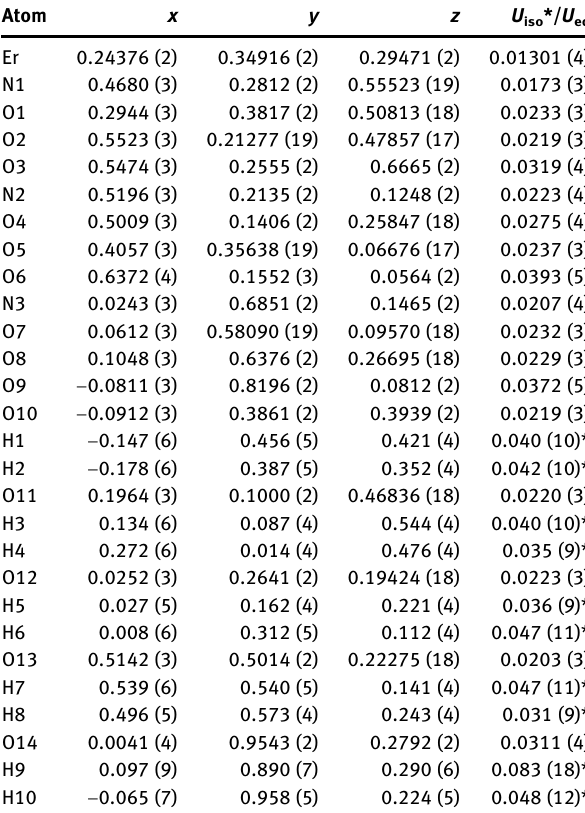
Table  : Fractional atomic coordinates and isotropic or equivalent isotropic displacement parameters (Å  ).